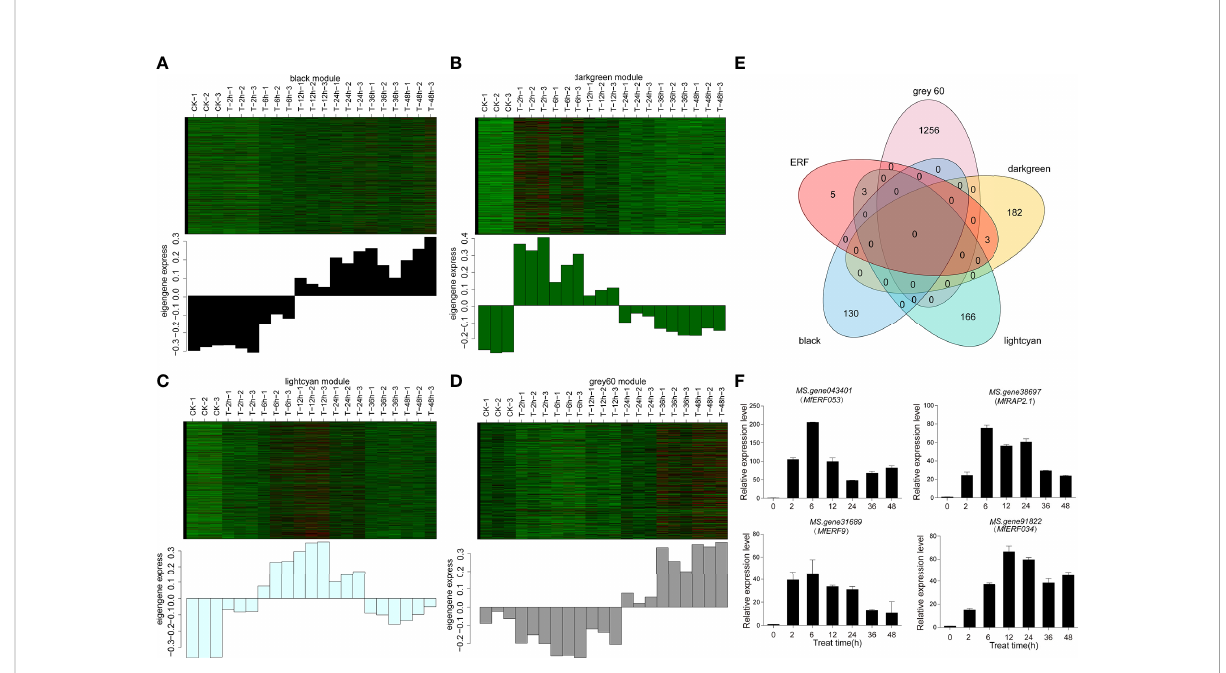
FIGURE 4 Differential candidate gene analysis. (A – D) , Heat map of gene expression pattern of each module. The above fi gure showed the expression level map of genes in modules in different samples; The following fi gure shows the characteristic values of modules in different samples. (A – D) represent darkgreen, lightcyan, black and gray60 module, respectively. (E) , The number of transcription factors differentially expressed in the fi ve candidate combinations were screened by Venn map. Black, lightcyan, darkgreen and grey60 represent the three candidate modules screened by WGCNA, and ERF represents the number of ERF genes common shared by all treatments and controls. (F) , The expression level of four MfERF genes under mannitol treatment at different time point as detected by